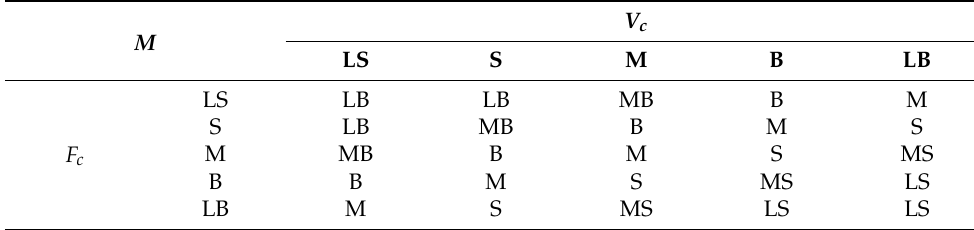
Table 1. Fuzzy rules of desired mass M .